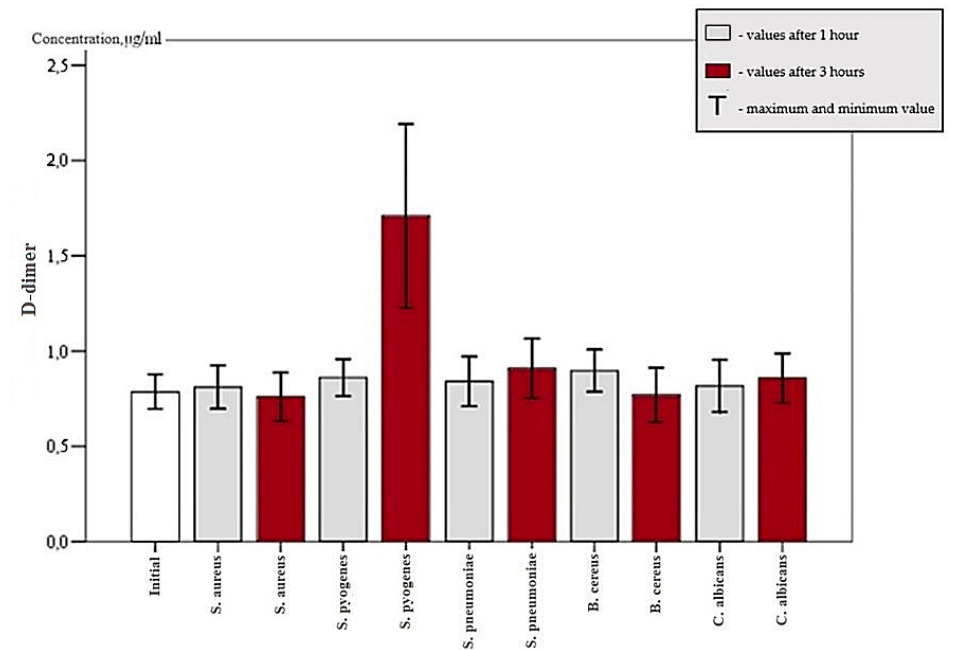
Figure 3. D -dimer concentration in all groups after one hour and after three hours. Figure 3. d -dimer concentration in all groups after one hour and after three